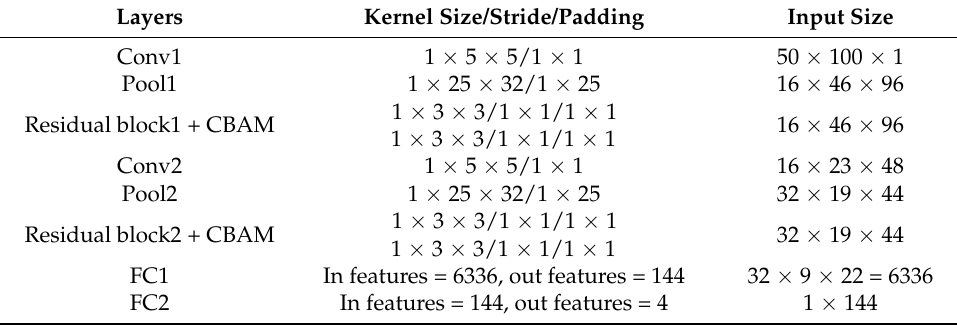
Table 4. Structural parameters of the 2 ‐ D CNN+CBAM network. Table 3. Structural parameters of the ResNet+CBAM network.